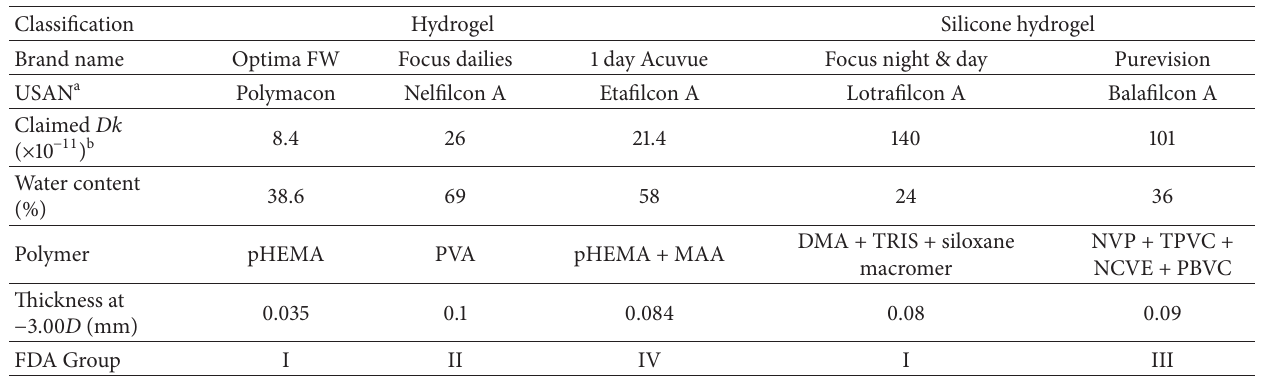
Table 1: Characteristics of contact